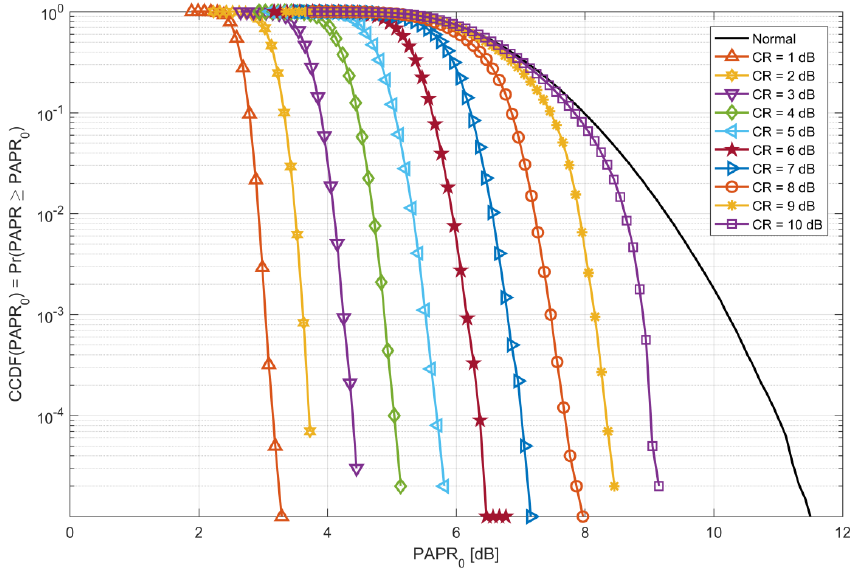
Figure 14. CCDF of PC-OFDM with 64-QAM for different Clipping Ratios.